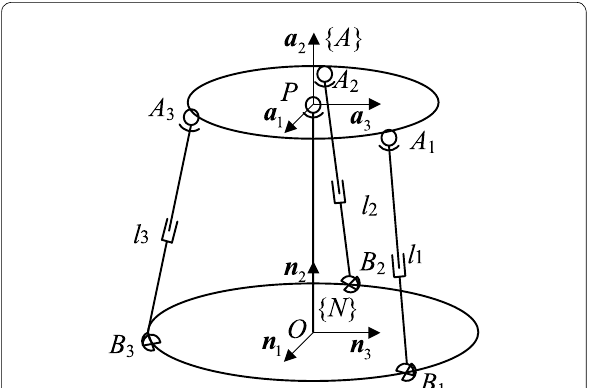
Figure 2 Coordinate system of the 3UPS/S manipulator